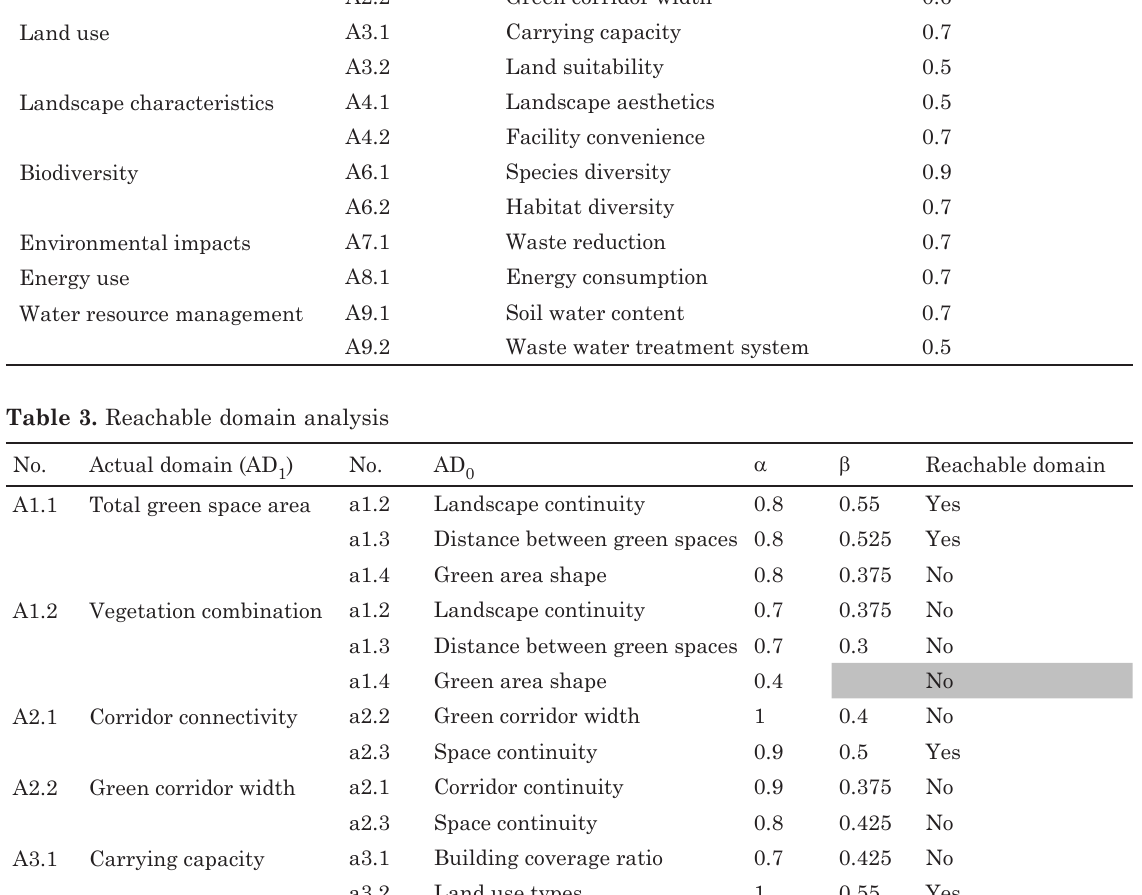
table 2. actual domains by interviewed experts (aD